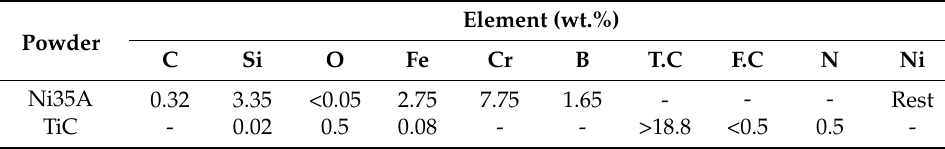
Table 1. Elemental composition (wt.%) of Ni35A and TiC powder.